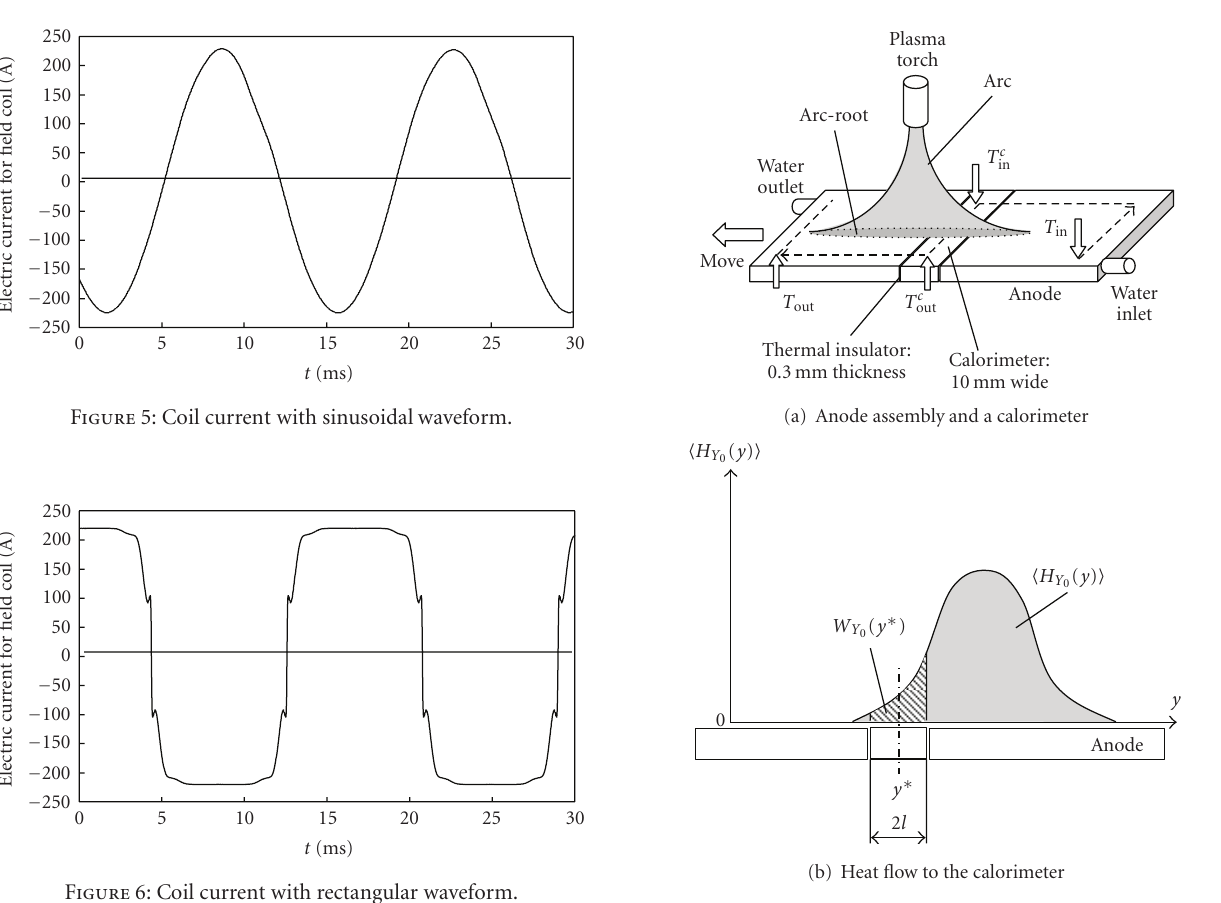
Figure 7: Anode assembly (a) and schematic representation of the heat flow to the calorimeter (b).